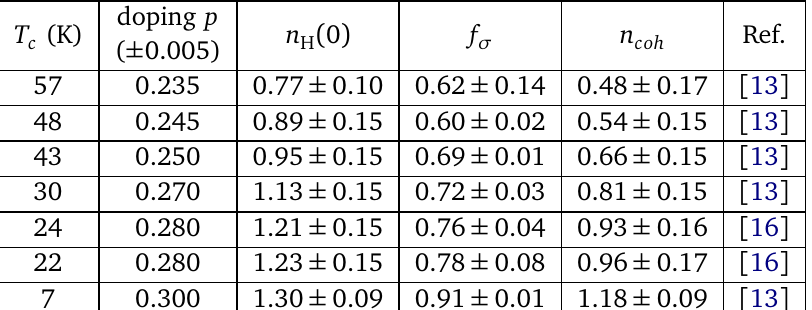
( 0 ) was determined H . The error bars for coh were calculated as composite coh ( 0 ) . H